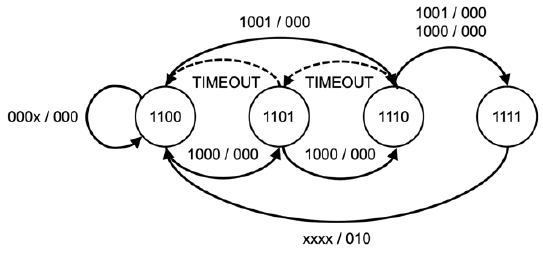
Figure 5. Disassociation KCSM.